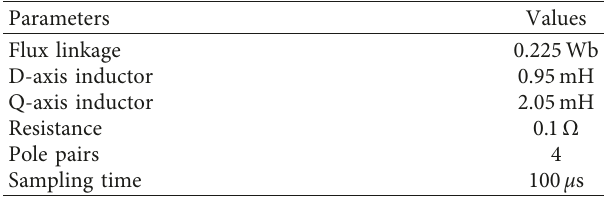
Figure 7: Flowchart of the conventional and proposed method. (a) The conventional method. (b) The proposed method. Table 3: Main parameters of the